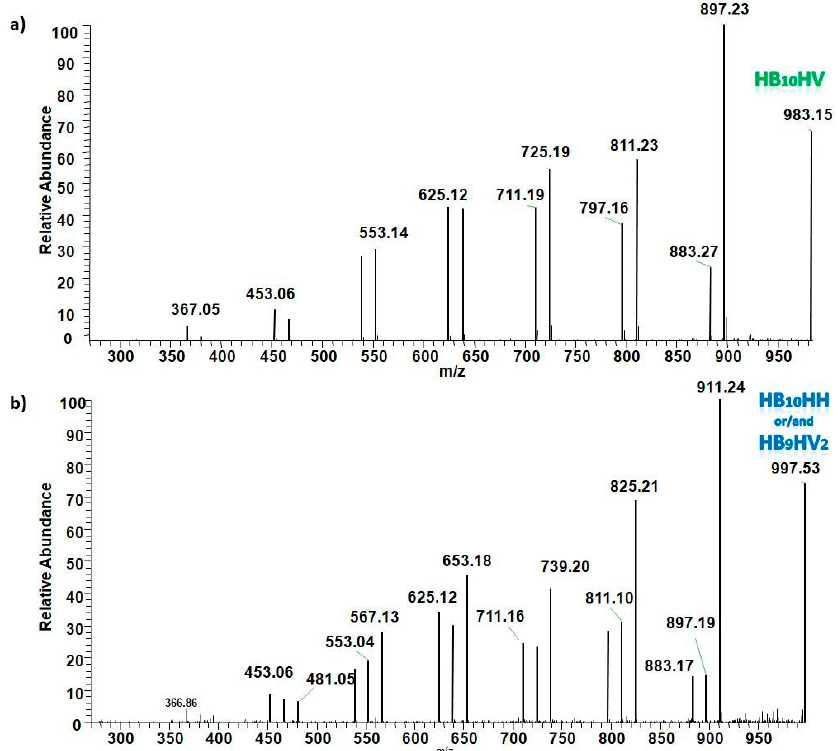
Figure 9. The ESI-MS / MS fragmentation spectra of selected sodium adducts of PHAs of [HB 10 HV + Na] + oligomers at m/z 983 ( a ) and of HB 9 HV 2 + Na] + or/and [HB 10 HH + Na] + oligomers at m/z 997 ( b ).